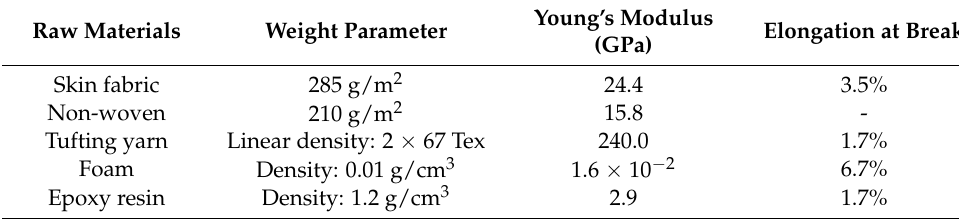
Table 2. Parameters of the raw